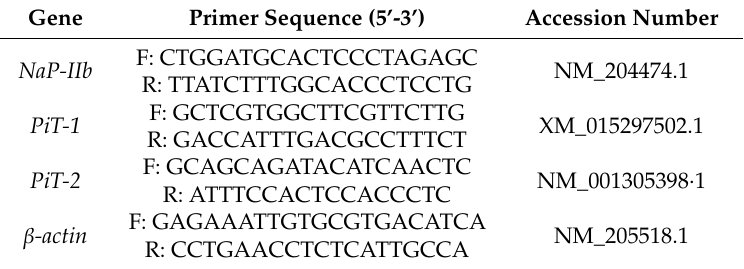
Table 2. Primer sequences of chicken NaP-IIb ; PiT-1, 2 ; and β